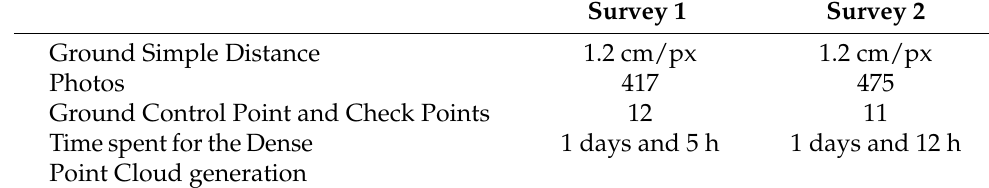
Table 7. Data related to the photogrammetric